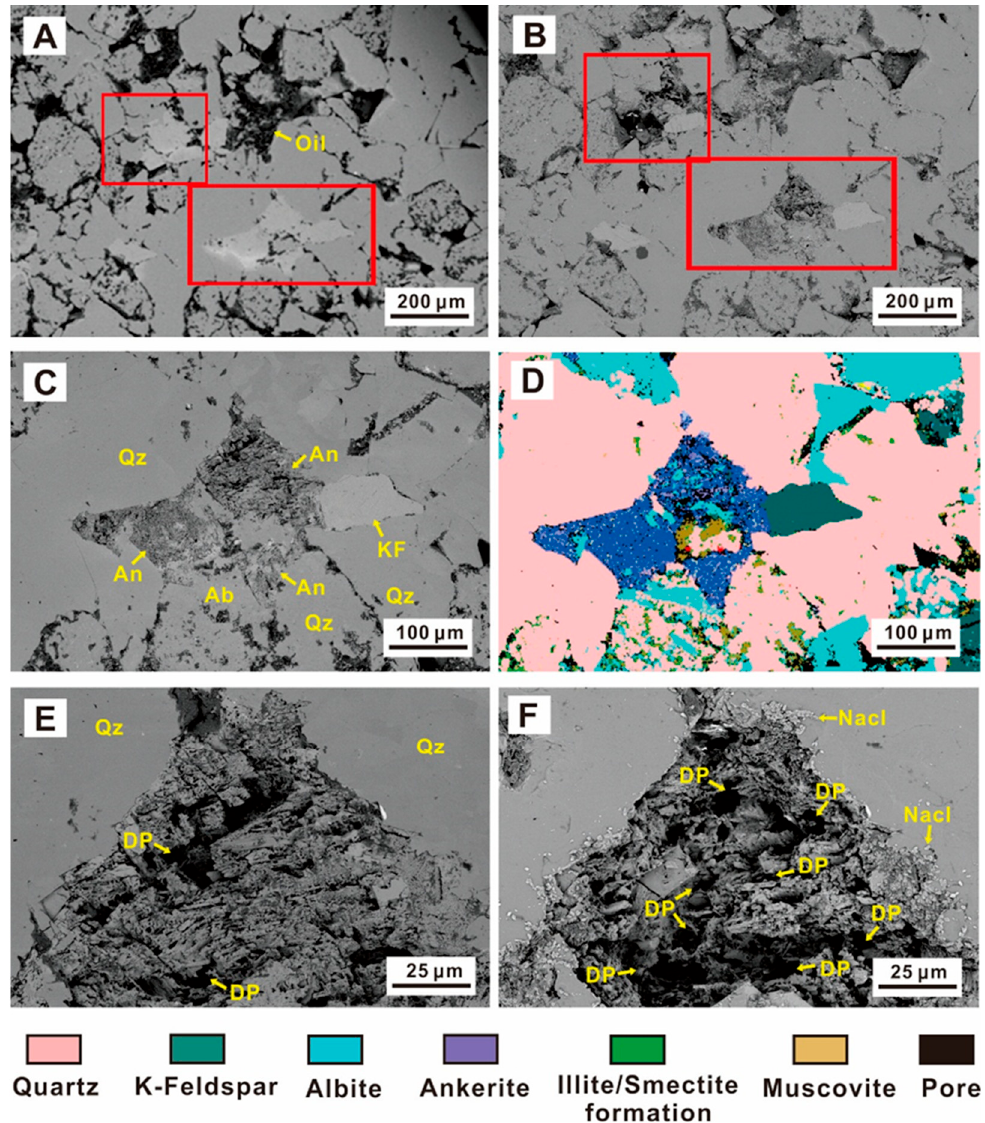
Figure 5. SEM images of typical mineral changes during the experiment. (An—ankerite, Ab—albite, KF—K-feldspar DP—Dissolution pores) ( A ) initial sample; ( B ) sample after 432 h of the experiment; ( C ) the dissolution position after 192 h of experiment; ( D ) QEMSCAN mineral analysis; ( E ) ankerite dissolution after 192 h; ( F ) ankerite dissolution at 432 h.